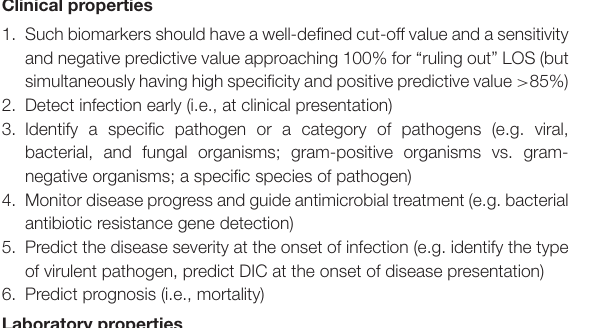
TABLE 1 | Criteria for an ideal biomarker or test for the diagnosis of neonatal sepsis (63). Clinical